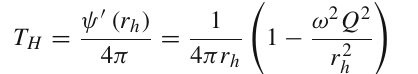
for γ = 0 . 0000 (cid:5) (cid:6) Fig. 4 Plots of ω with respect to γ for various value of q = Q e Q m Q e = 0 ... 2 with equal steps. The dashed curve is for the particular q = 0 . 7 Q m andthethreeregionscoloredwithgreen(left),white(middle),andlight- blue (right) imply ω decreasing and less than 1, increasing and less than 1, and increasing and greater than 1, respectively. For q ≥ 1 , the curve of ω is increasing with respect to γ . These curves are depicted above the sign of q =